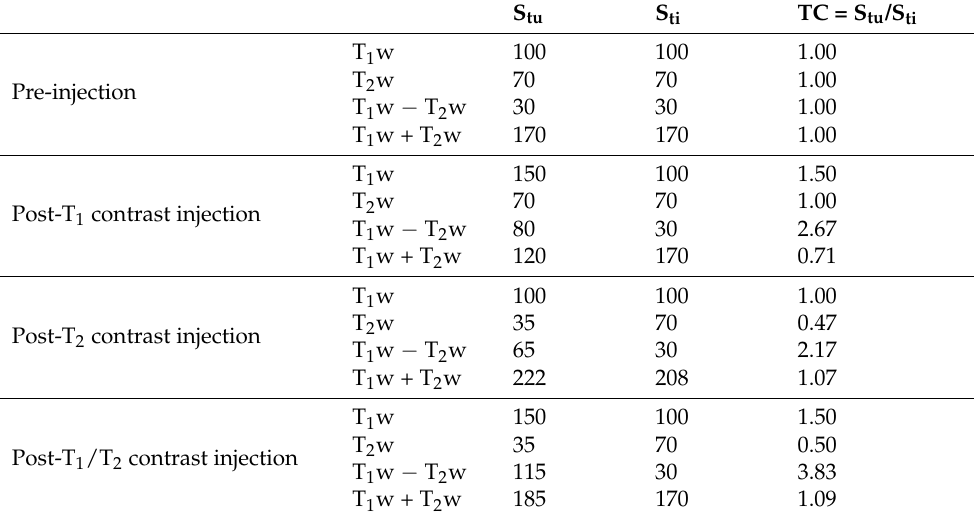
Table 1. The signal values from the phantom model of tumor (S tu ), normal adjacent tissue (S ti ), and the corresponding contrast, were obtained before and after the application of the “perfect” T 1 , T 2 , and T 1 /T 2 contrast agents. Contrast values (TC) obtained by subtraction (T 1 w − T 2 w) and addition (T 1 w + T 2 w) of signals are also